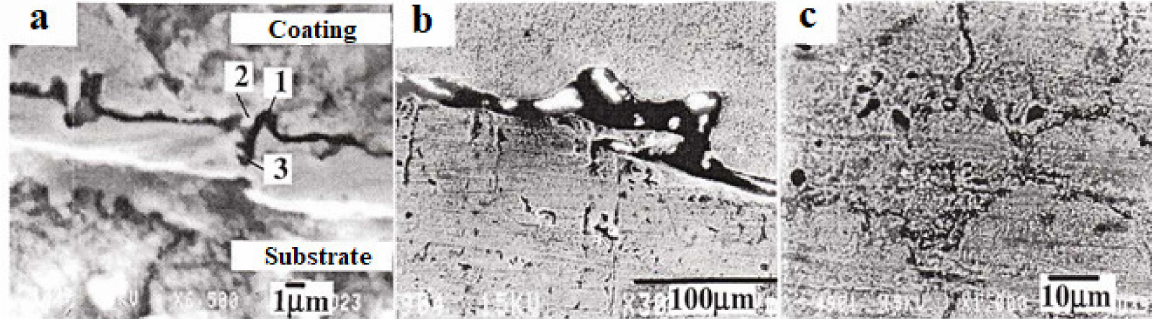
Figure 10. Micrographs of a vertical section of the coated sample: ( a ) microcumulative fragments at the coating–substrate interface: 1—pestle; 2—incomplete cumulative notch; 3—beginning of the channel for superdeep penetration of the micro- cumulative jet; ( b ) channels of superdeep penetration; ( c ) the ends of the superdeep penetration channels, the upper border of the image corresponds to a depth of 110 µ m from the substrate surface.